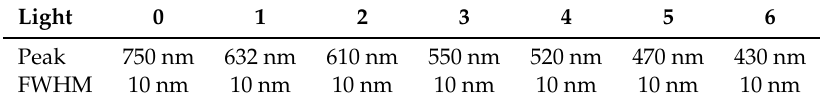
Table 1. Peak wavelength and full width at half maximum (FWHM) for each light